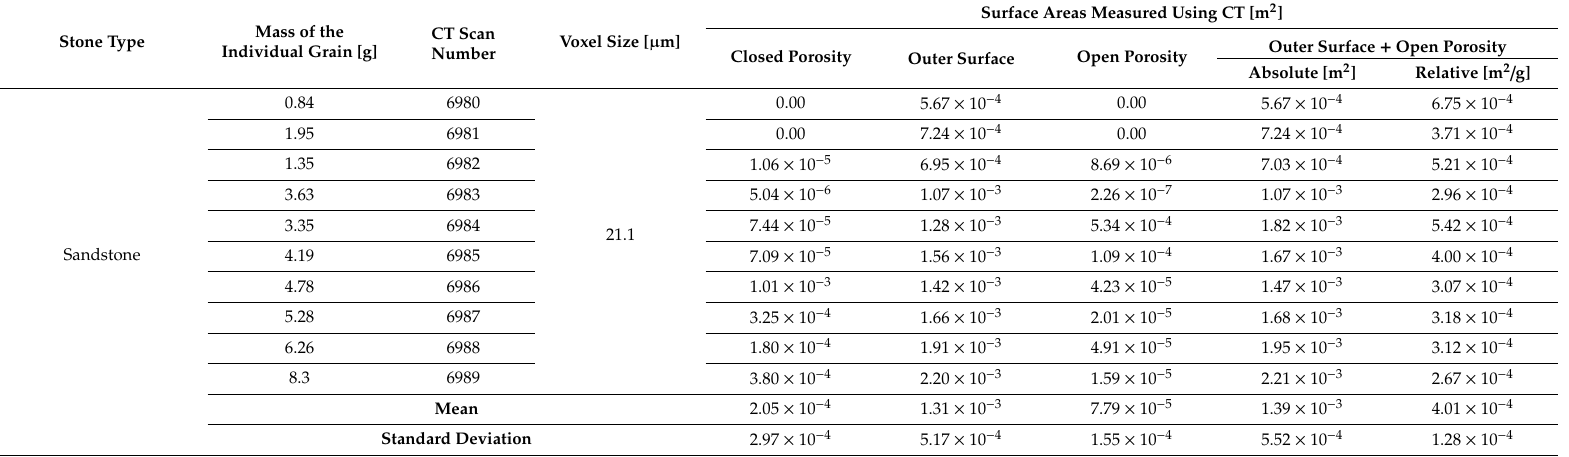
Table A4. Individual grain results from the cracking analysis of stone category GK4 (river gravel; alkali sensitivity EI-S). Stone Type